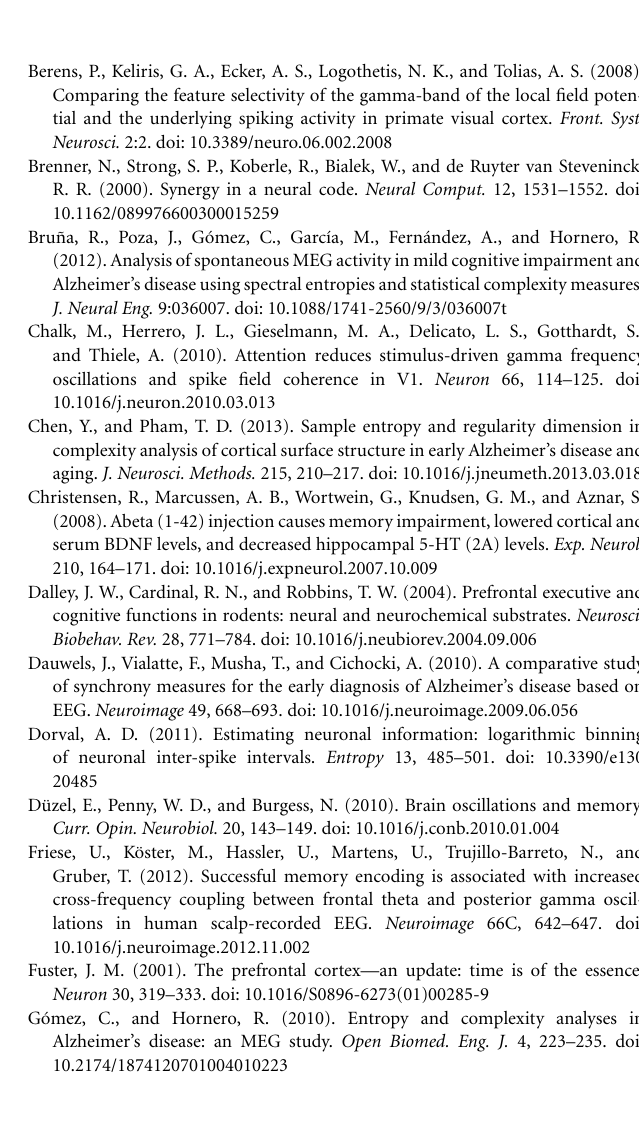
Table 6 | Spike-LFP correlation in correct and incorrect trials in the A β group. Correct Incorrect Peak Averaged Peak Averaged Spike-LFP